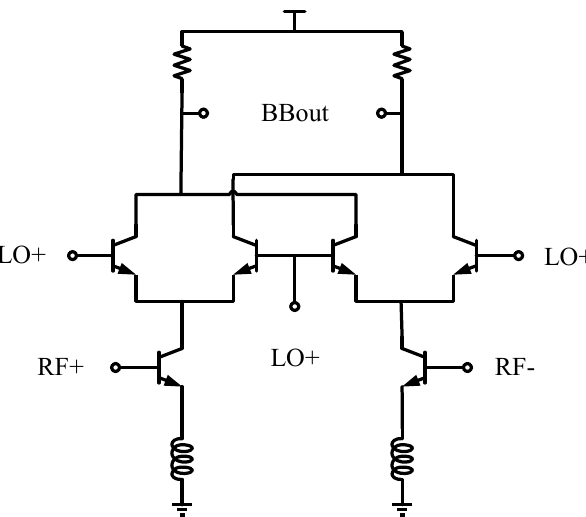
Figure 4. The schematic of the down-conversion mixer.